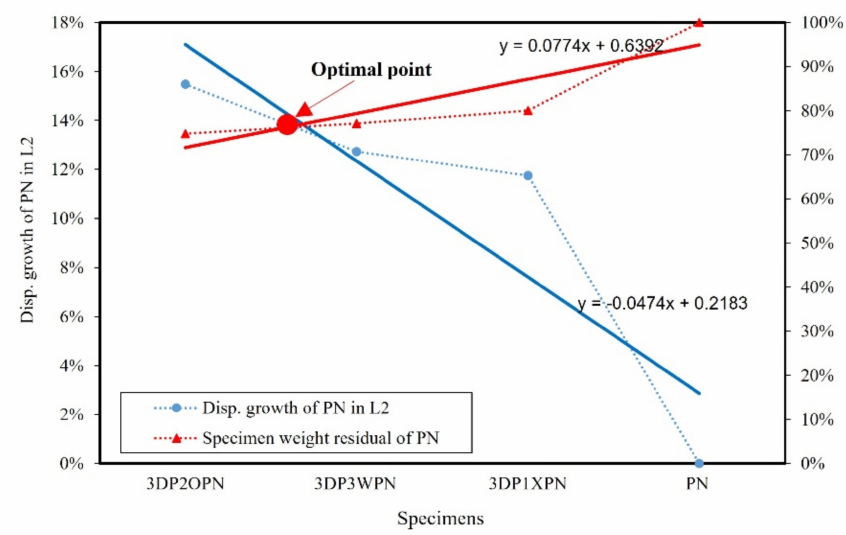
Figure 22. Optimal point of the FEM analysis in loading protocol #2